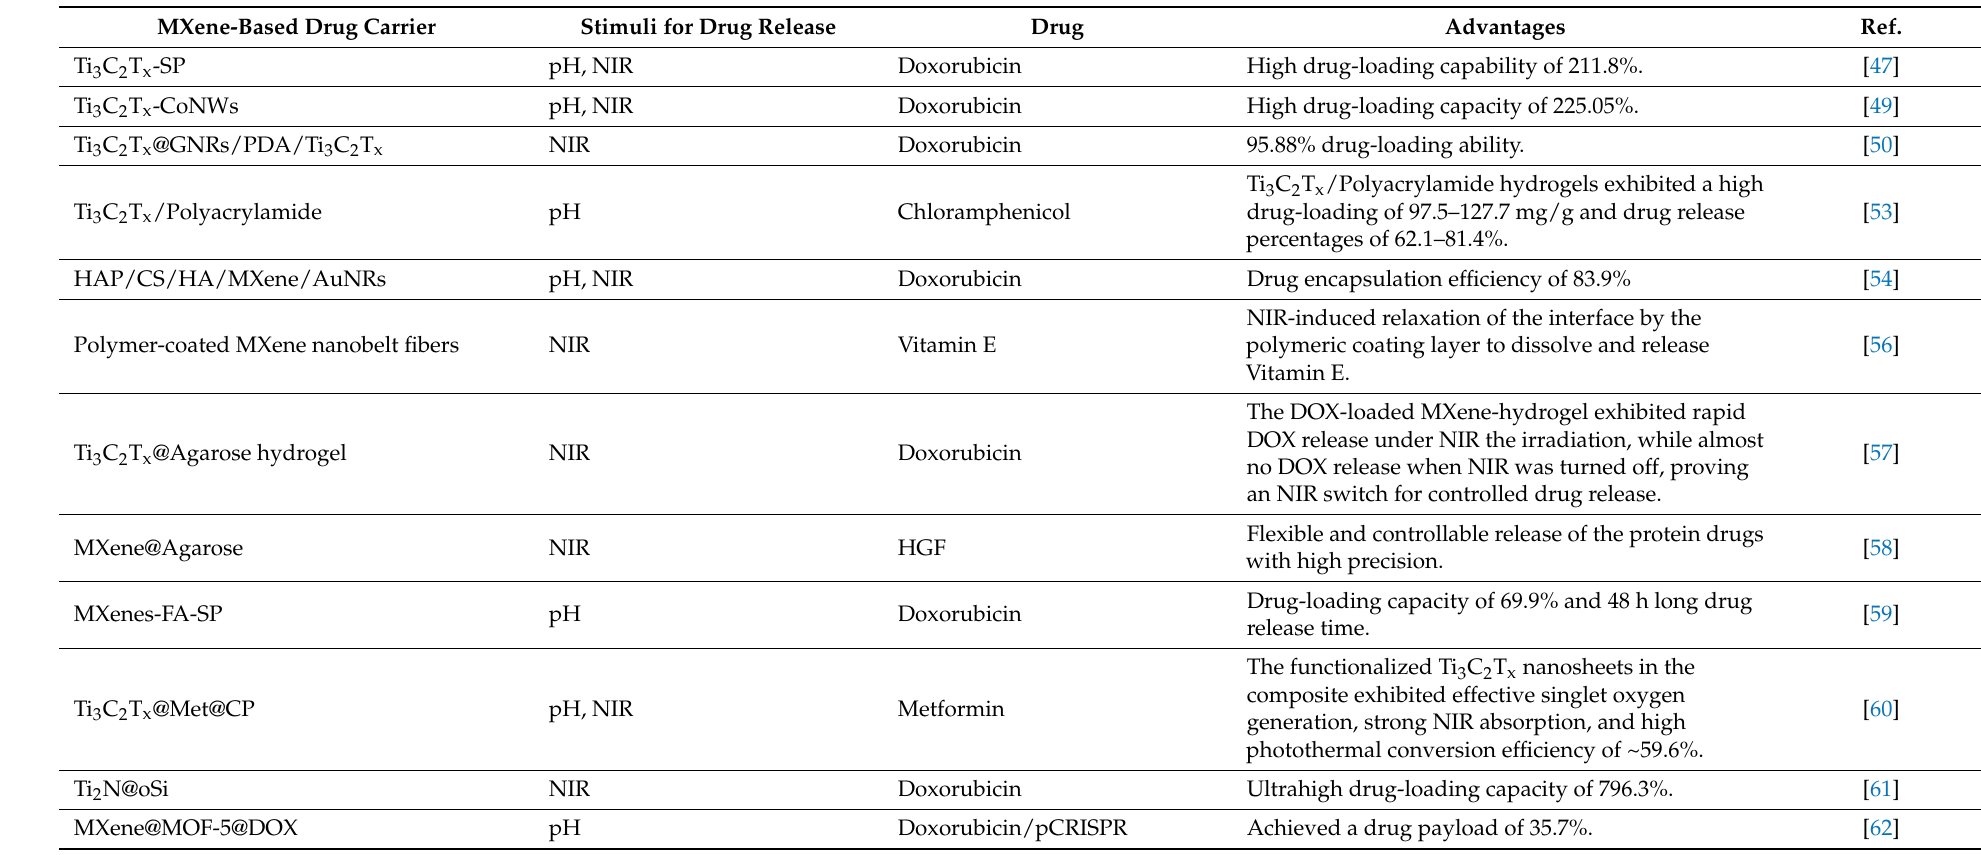
Table 1. Literature reports of MXenes for drug delivery